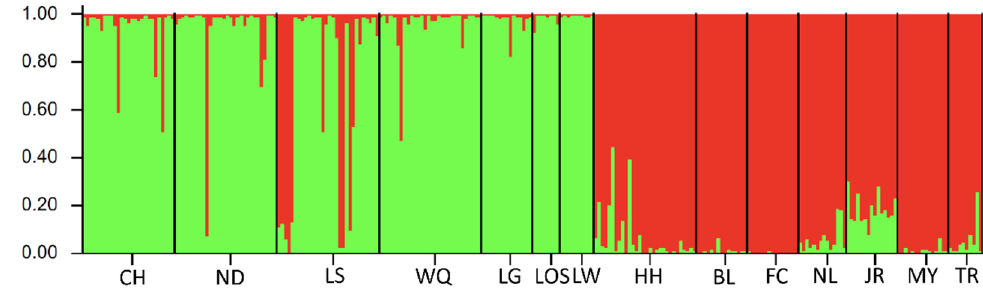
Figure 7. Results of STRUCTURE analysis for 264 O. hainanensis individuals based on microsatellite data. Estimated population structure for K = 2 using the method by Evano [46]. Each individual is represented by a vertical-colored bar, and the separation of the column into two colors represents the probability of membership in the relevant cluster. The x -axis represents individual samples and y -axis represents the proportion of belonging to a certain cluster. Black solid vertical lines separate each population whose names were indicated (code name given in Table 1).